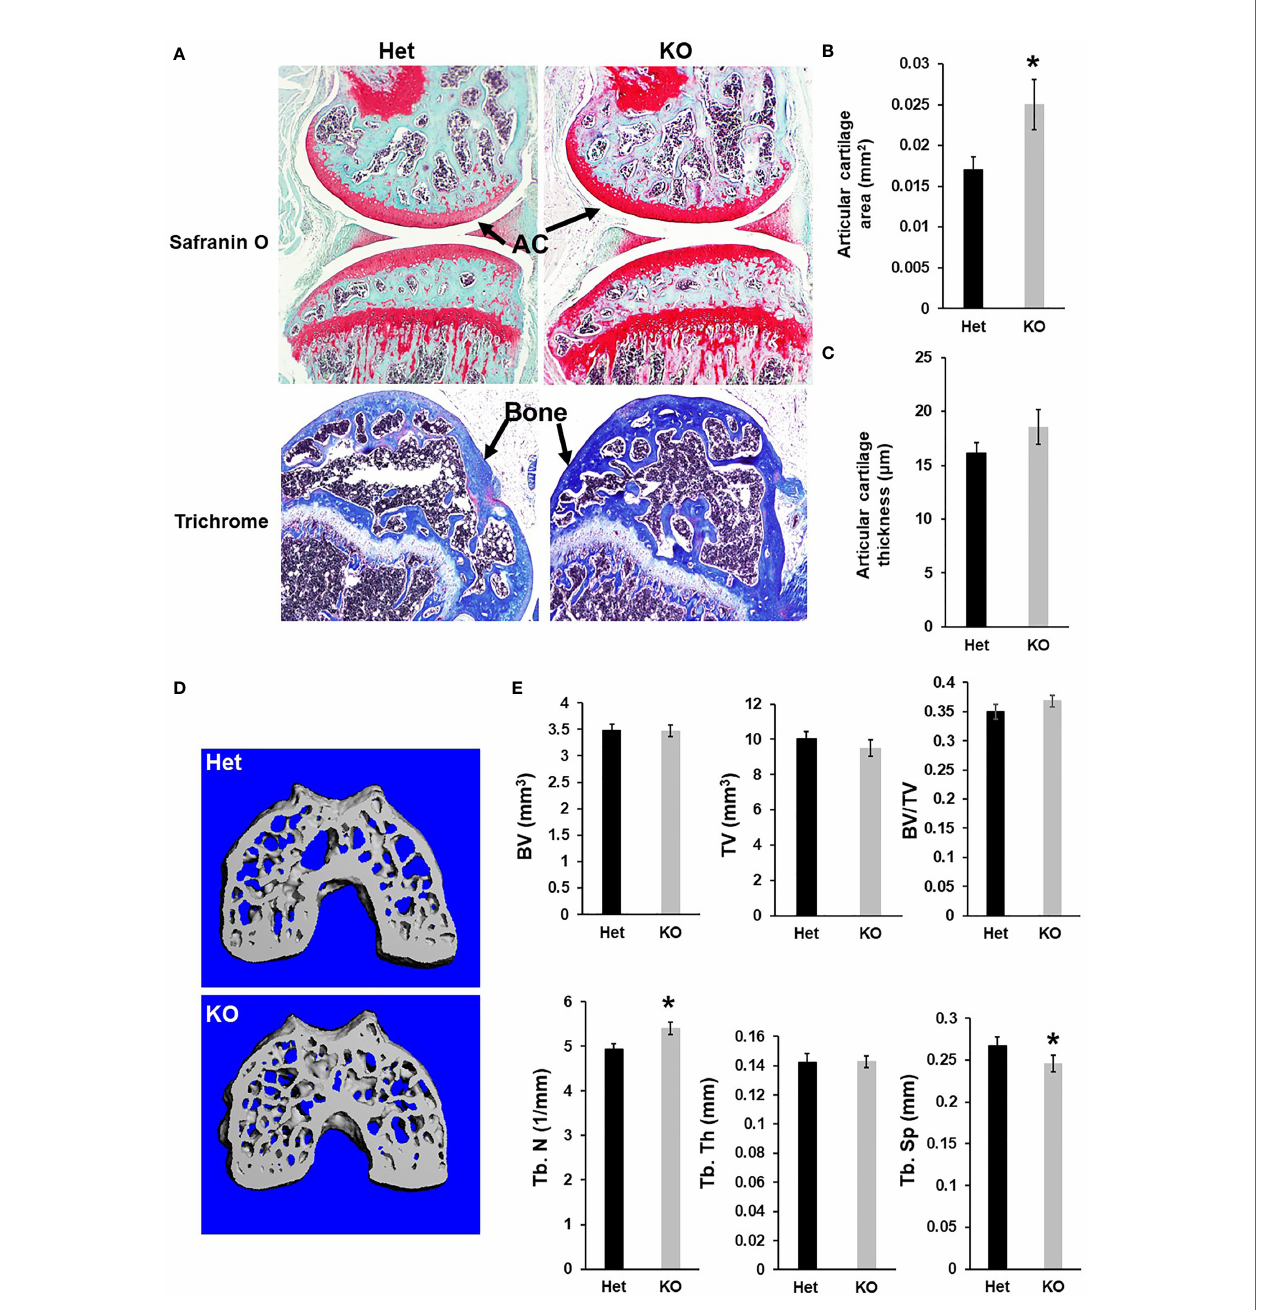
FIGURE 3 | Mice with disruption of Cldn12 exhibit increased articular cartilage area of the distal femur. (A) Longitudinal section images of the knees of the Cldn12 KO and control heterozygous mice, stained with safranin orange. The distal femoral epiphyses of the Cldn12 KO and control heterozygous mice were stained with trichrome blue and counter-stained with safranin orange. (B, C) Quantitative histomorphometry data of the articular cartilage area and thickness of the knee, respectively. (D) Micro-CT images of the cress sections of the distal femoral epiphyses. (E) Quantitative micro-CT data of the trabecular bone parameters of the distal femoral epiphyses, respectively. TV, tissue volume; BV, bone volume; Tb. N, trabecular number; Tb.Th, trabecular thickness; Tb.Sp, trabecular spacing. Values are Mean ± SEM (n=8). A star (*) indicates P<0.05, as compared to the control